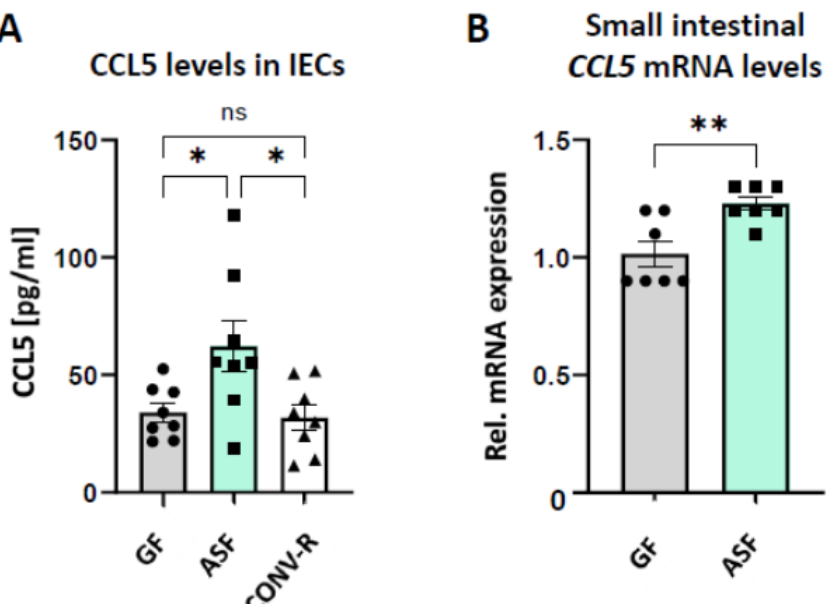
Figure 3. Expression of CCL5 (RANTES) in isolated small intestinal epithelial cells and in the mid small intestine of gnotobiotic ASF-colonized mice relative to GF controls. ( A ). ELISA quantification of CCL5 protein levels in primary intestinal epithelial cell lysates from GF, ASF-colonized, and CONV-R C57BL/6J mice (N = 8 mice per group). ( B ). qRT-PCR quantification of small intestinal CCL5 mRNA levels in GF relative to ASF-colonized C57BL/6J mice (N = 7 mice per group). All data are expressed as means ± SEM. Statistical comparisons were performed using one-way